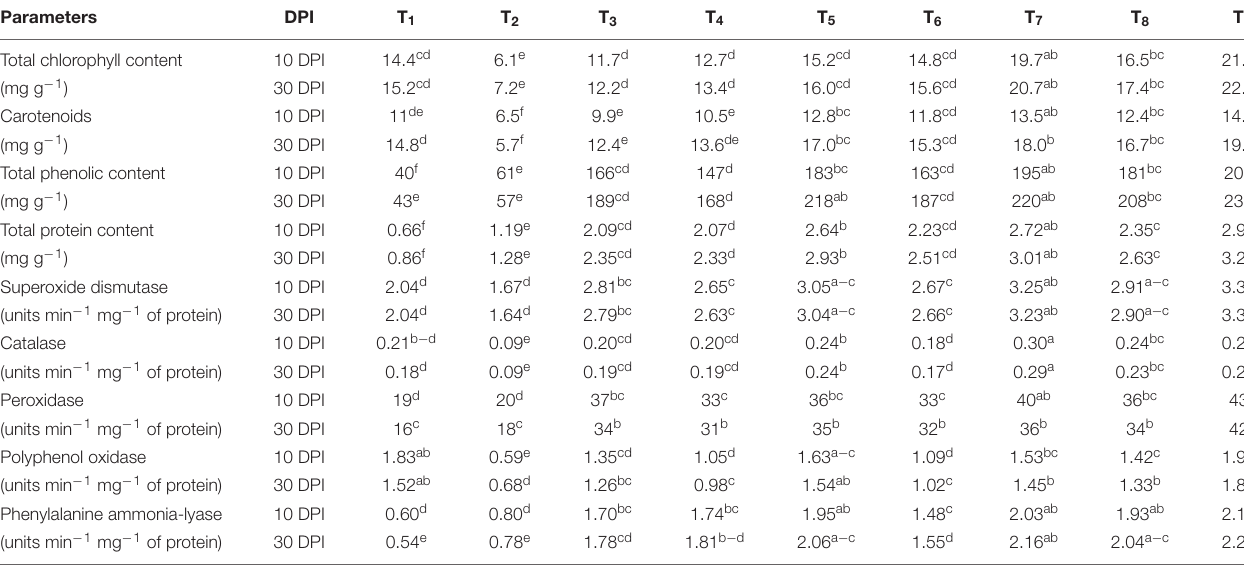
TABLE 4 | Effect of Bacillus subtilis (BS-01) and mineral nutrients [Zn (2X: 10 kg acre − 1 ) and NPK (64:46:50 kg acre − 1 )] on the physio-chemical attributes in tomato plants inoculated with Alternaria solani (AS) in the field after 10 and 30 days of pathogen inoculation (DPI). Parameters